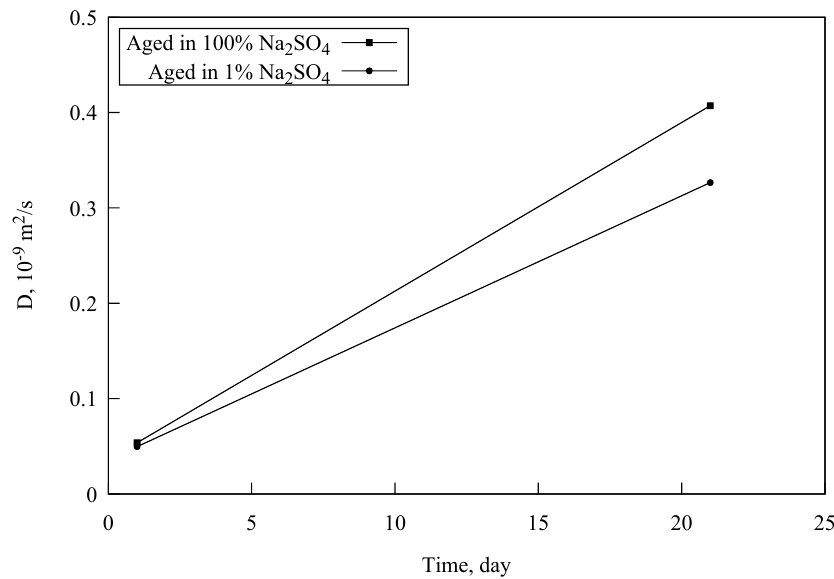
Figure 15. Diffusion coefficient behavior of Berea Sandstone before and after the aging process in 1% Na 2 SO 4 and 100% Na 2 SO 4 at 25 ◦